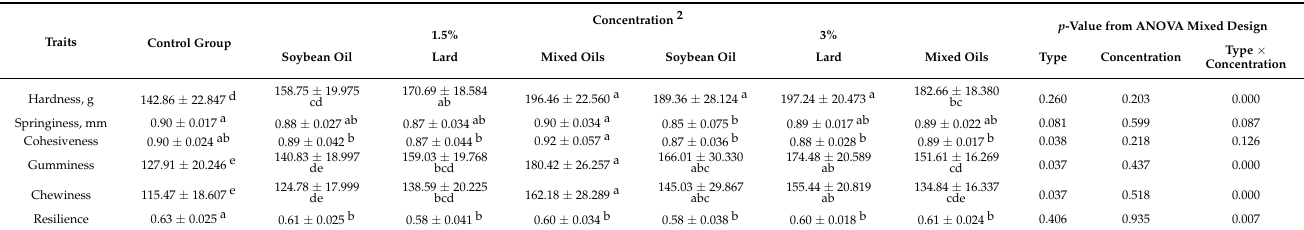
Table 8. Effect of different concentrations of soybean oil, lard, and mixed oils on the texture profile analysis of cooked egg yolk 1